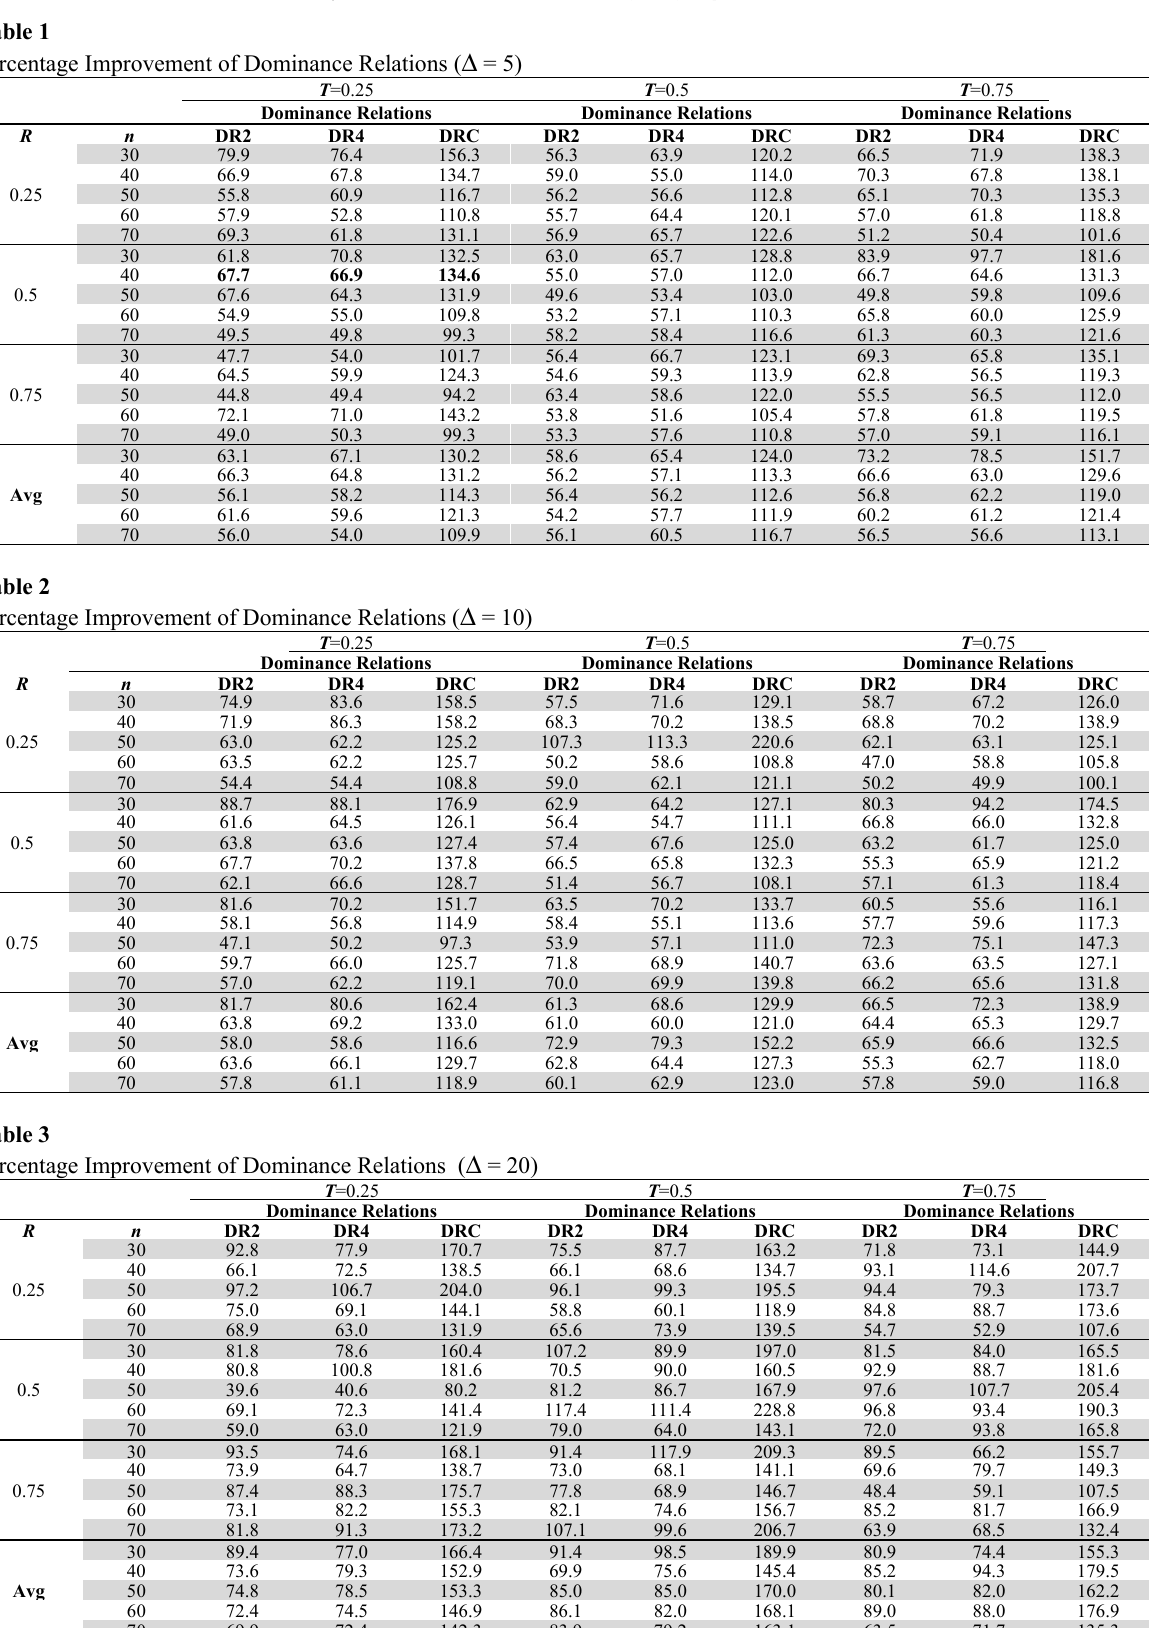
Table 1 Percentage Improvement of Dominance Relations ( Δ = 5) T =0.25 T =0.5 T =0.75 Dominance Relations